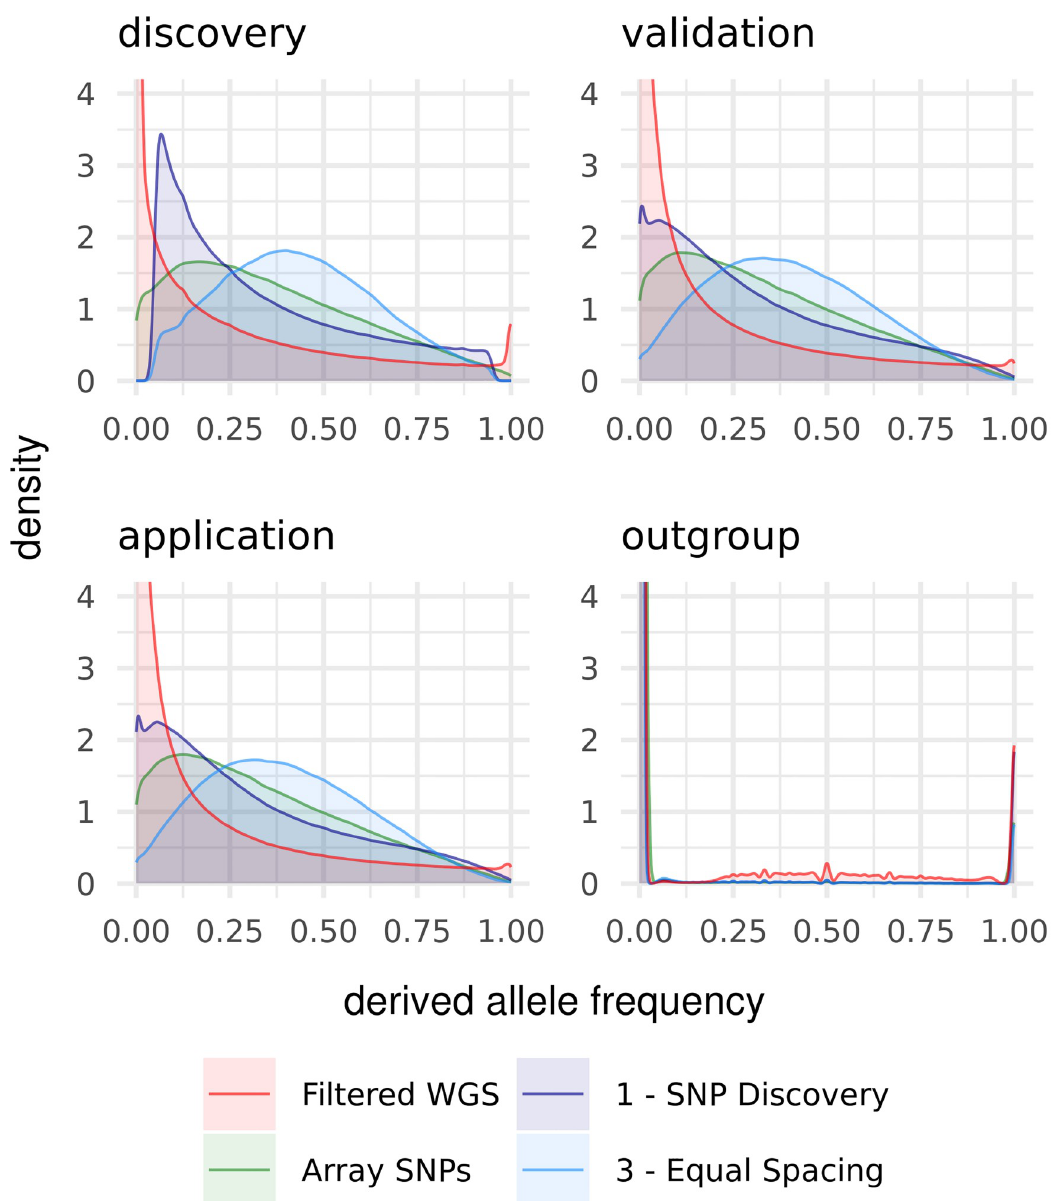
Fig 3. Derived allele frequency spectra within the population